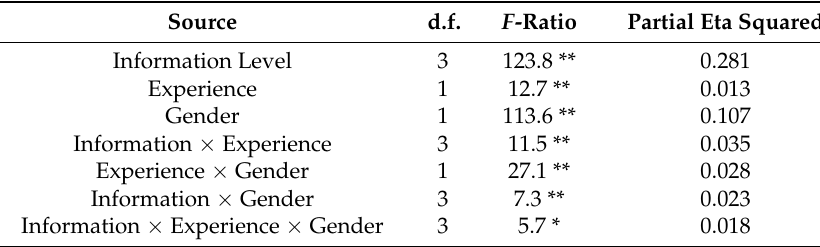
Table 7. Analysis of variance results for driving